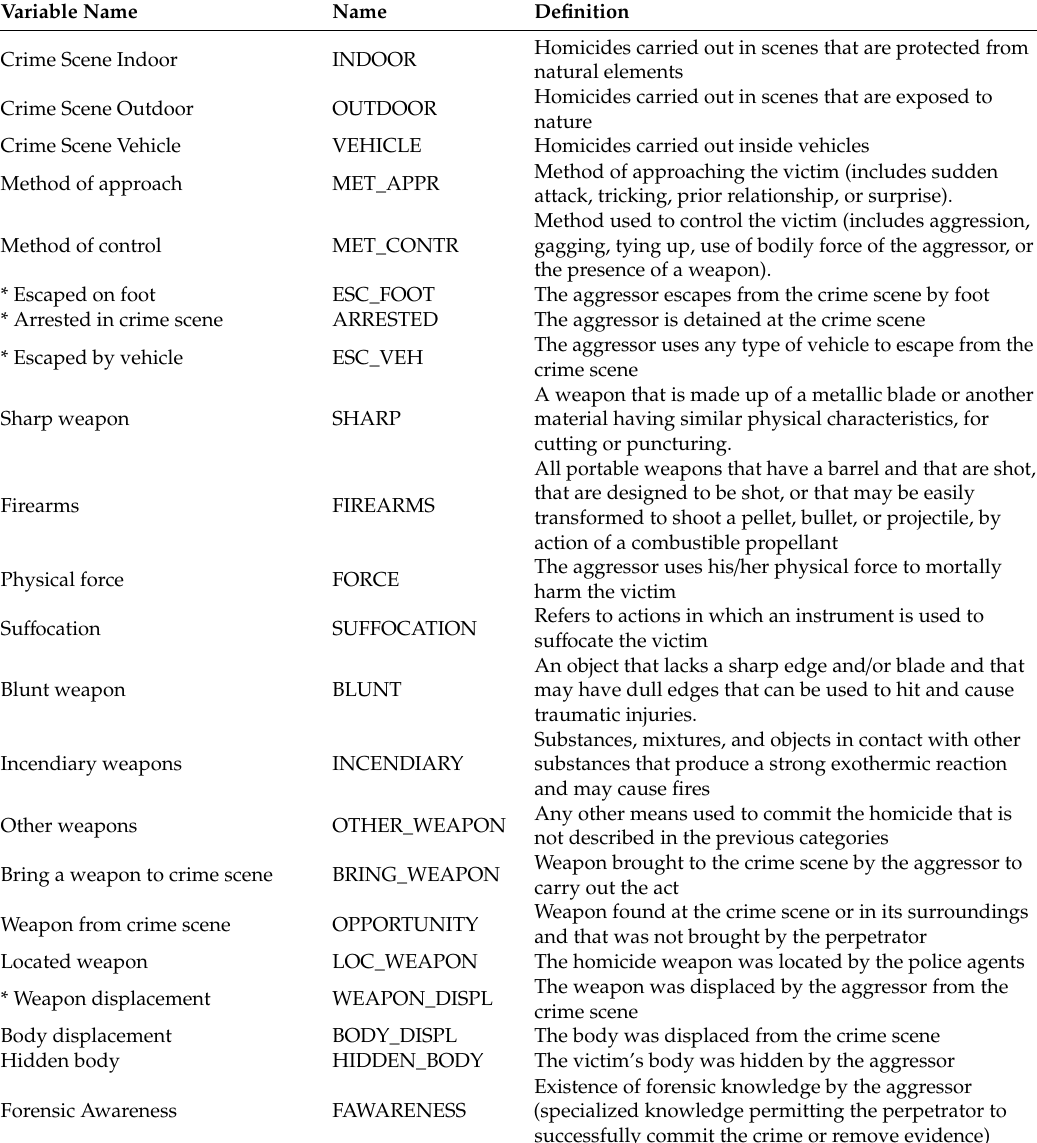
Table 1. Variables used in the instrumental / expressive model and their